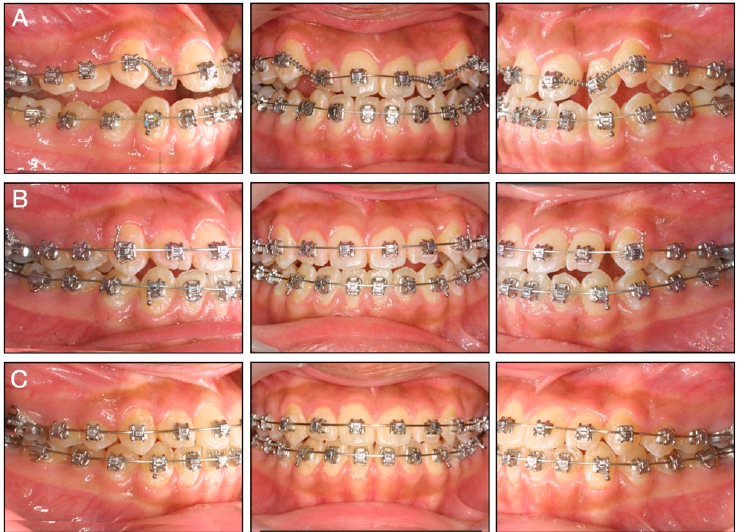
Figure 3. Case 1, Treatment progress at ( A ) 2nd month ( B ) 4th month ( C ) 8th month shows correction of anterior crossbite and Class III malocclusion.